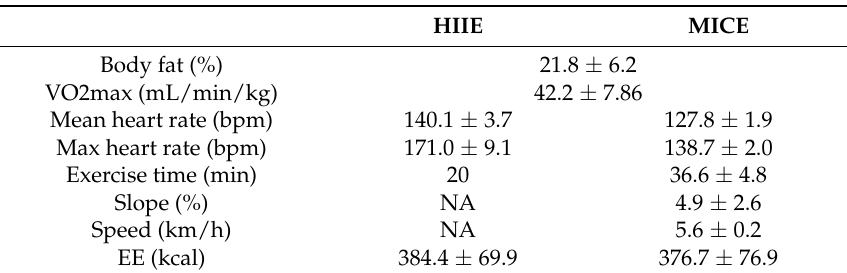
Table 1. Exercise